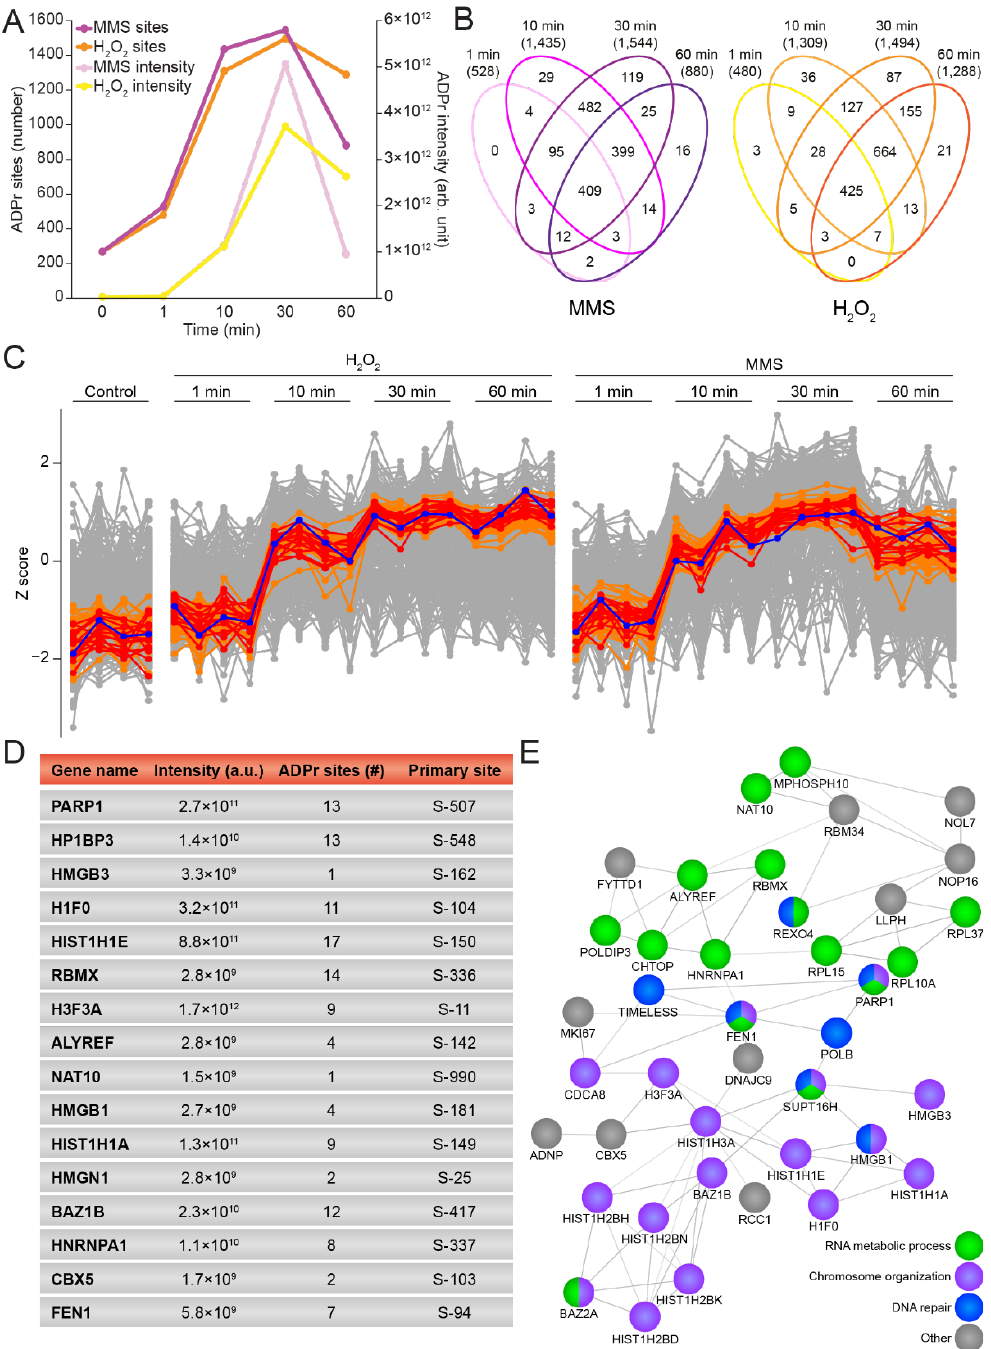
Figure 3. General temporal properties of the H 2 O 2 - and MMS-induced ADP-ribosylome. ( A ) Line graph showing the temporal effect on the total number of ADPr sites and the summed ADPr intensity for MMS and H 2 O 2 . Control condition corresponds to the 0 min time point. ( B ) Venn diagram depicting the number of identified and localized ADPr sites upon different treatment times with MMS (left panel) and H 2 O 2 (right panel). ( C ) Profile cluster analysis illustrating the temporal properties of PARP1 (blue line) and the top 15 proteins (red lines) or top 50 proteins (orange lines) with the most similar profiles to PARP1. ( D ) Table including PARP1 and the 15 proteins showing the most similar profiles to PARP1. ( E ) STRING network showing interactions between the 50 proteins showing the most similar profiles to PARP1. Default STRING clustering was used ( p > 0.4) except for disabling of text mining, and disconnected proteins were omitted from the network. Proteins were annotated with colors as highlighted in the figure legend.